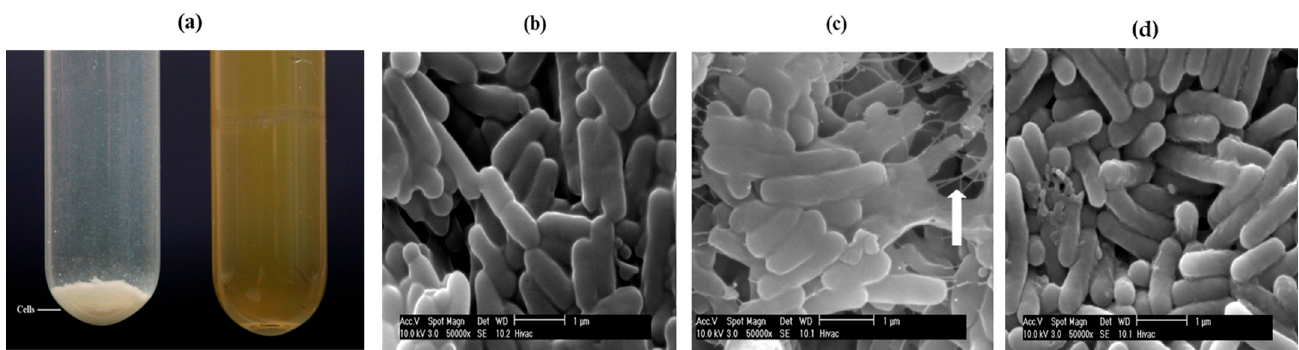
Figure 1. Cells of L. monocytogenes (Lm1040S) grown in MCDB 202 (showing flocculated cells) and brain heart infusion (BHI) media at 37 °C for 18 h ( a ). SEM micrographs were captured for cells grown in BHI ( b ) and D10 ( c ) and MCDB 202 ( d ) media. Cells were grown for 18 h with shaking at 37 °C and then harvested from the broth by centrifugation. Cells were re-suspended in PBS, fixed on electron stubs and coated with platinum before viewing. The white arrow ( c ) indicates an area where a thick layer of an extracellular polymeric substance (EPS) can be seen joining cells.